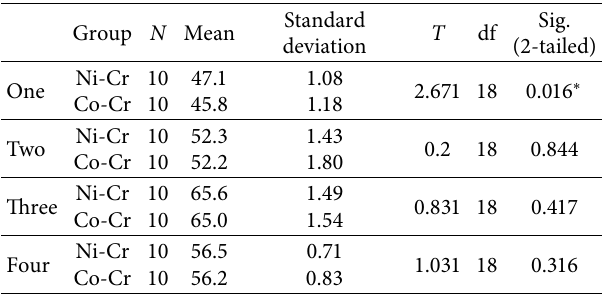
Figure 2: Intergroup comparison of shear bond strength of Ni-Cr and Co-Cr alloy samples. Table 5: Intergroup comparison of shear bond strength of Ni-Cr and Co-Cr alloy samples using unpaired t -test.